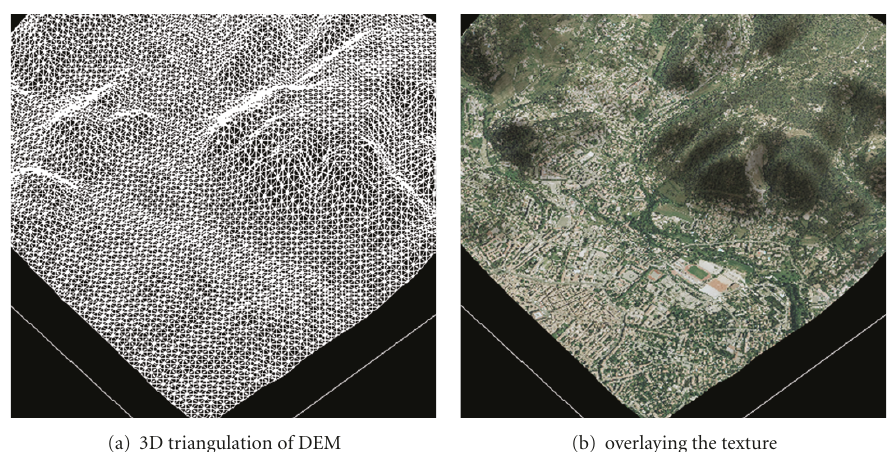
Figure 18: 3D views obtained with the original ( l h = l m = l l = 0).